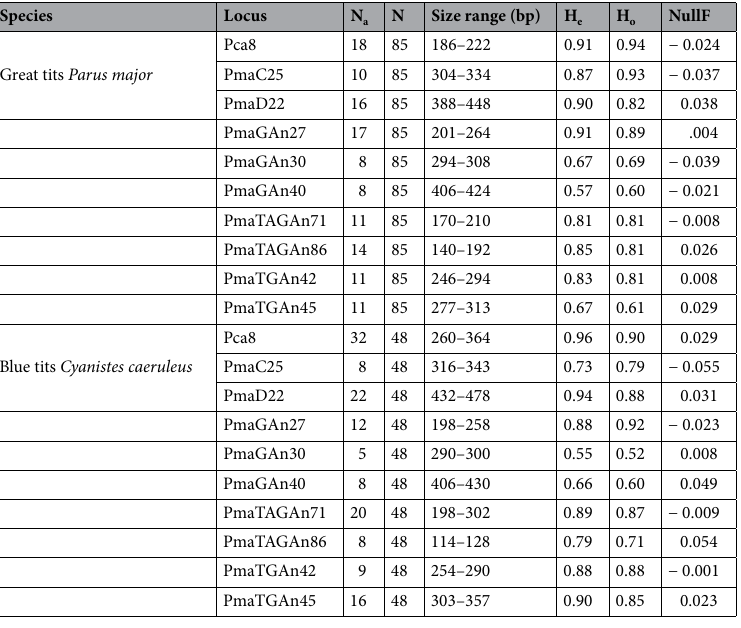
Table 1. Summary of ten microsatellite loci characteristics for the great and blue tits including number of alleles per locus (N a ), number of individuals (N), allele size ranges, expected heterozygosity (H e ), observed heterozygosity (H o ) and frequency of null alleles